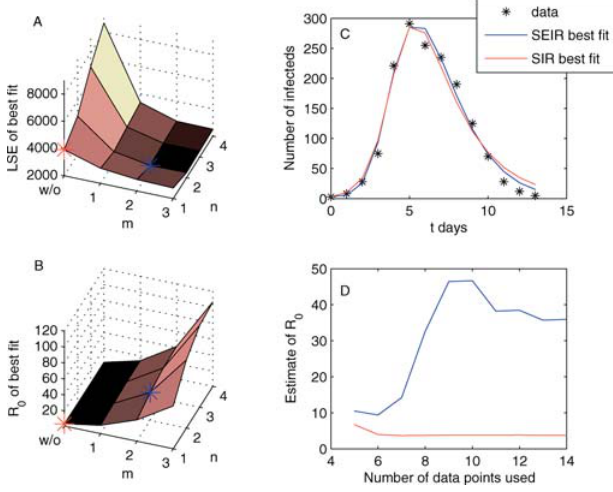
Figure 3. Fitting Epidemic Models to Data from an Influenza Outbreak (A and B) The least squares error (LSE) (A) and R 0 (B) of the best-fit model under different assumptions about the distribution of the latent and infectious periods. (The label ‘‘ w/o ’’ denotes no latent class.) (C) We plot the incidence data along with the SEIR best fit (m ¼ 2, n ¼ 2) and that obtained by ignoring any latent period (n ¼ 1)—the SIR best fit. (D) The best-fit estimate of R 0 changes for these two models as we increase the number of points used in the fitting procedure. When fitting the models, for each value of n (and m), we are estimating the average infectious period, 1/ c , and transmission parameter, b (and average latent period, 1/ r ). The effective population size for the influenza outbreak was known to be N ¼ 763. DOI: